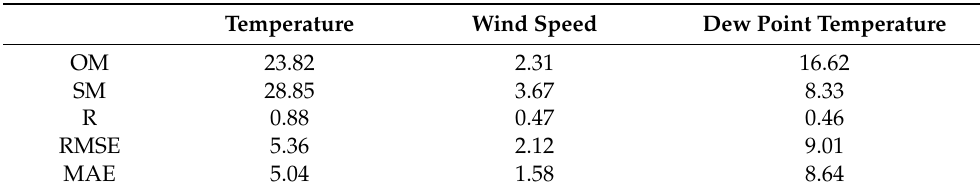
Table 3. WRF simulation performance assessments. OM represents observation mean value. SM represents simulation mean value. R represents the Pearson correlation value. RMSE represents Root Mean Squared Error and MAE represents mean absolute